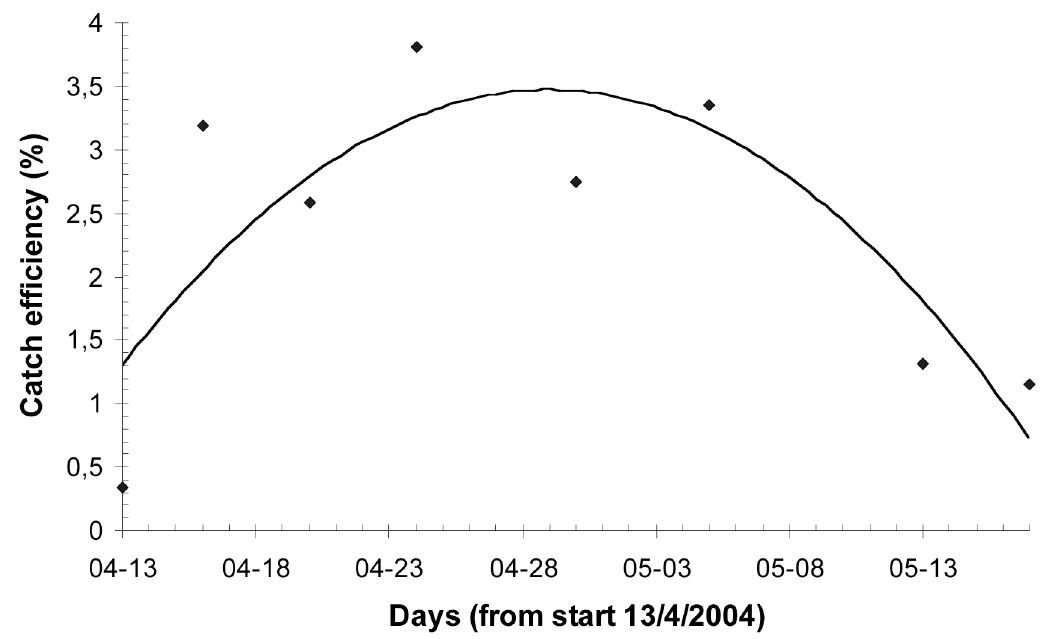
Fig. 2. Catch efficiency (percentage of the population size captured per trap night) of funnel traps in pond 7 during the study period. The number of immigrated adult individuals that was registered by means of drift fence and pitfall trapping was used as a population size estimate. R 2 =